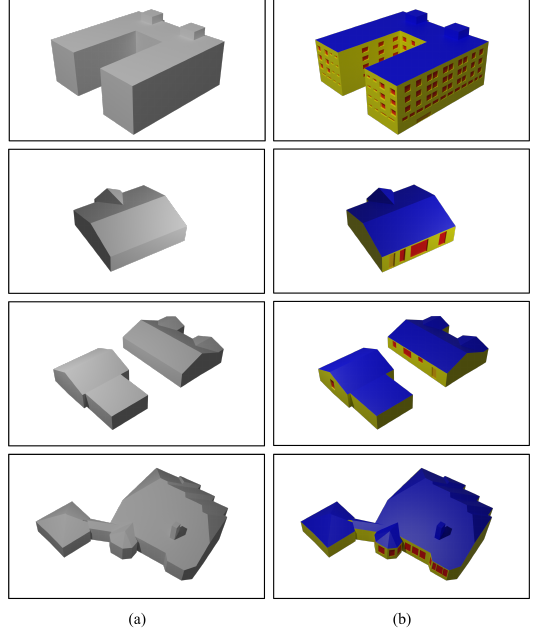
Figure 6. Visualization of fine grained models. The models generated by our algorithm before the process of fine-grained semantic generation are shown in ( a ). The models after applying fine-grained semantic parsing are displayed in ( b ).